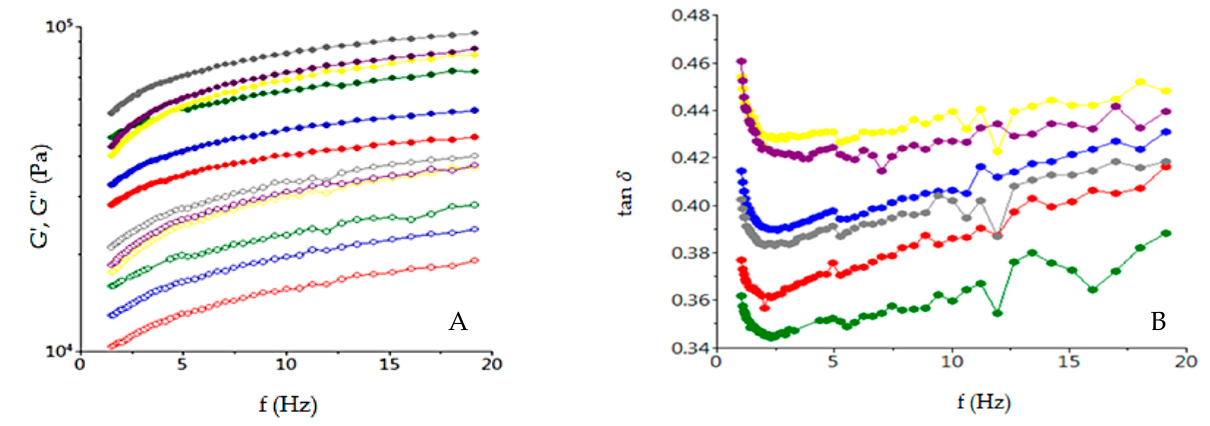
Figure 1. Evaluation with frequency of G’ (open symbols), G” (solid symbols) ( A ) and tan δ ( B ) for the samples with different